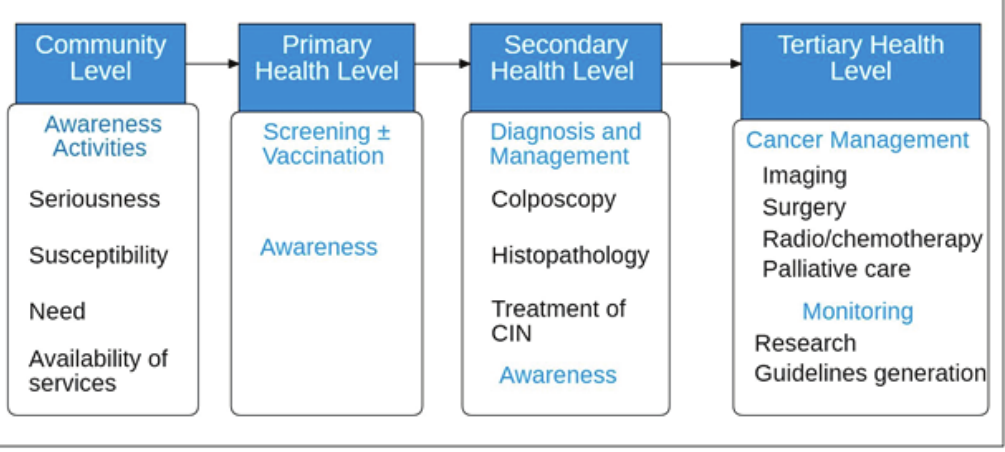
Figure 4: Configuration of cervical cancer services with distribution of services to the community level, primary, secondary, and tertiary health